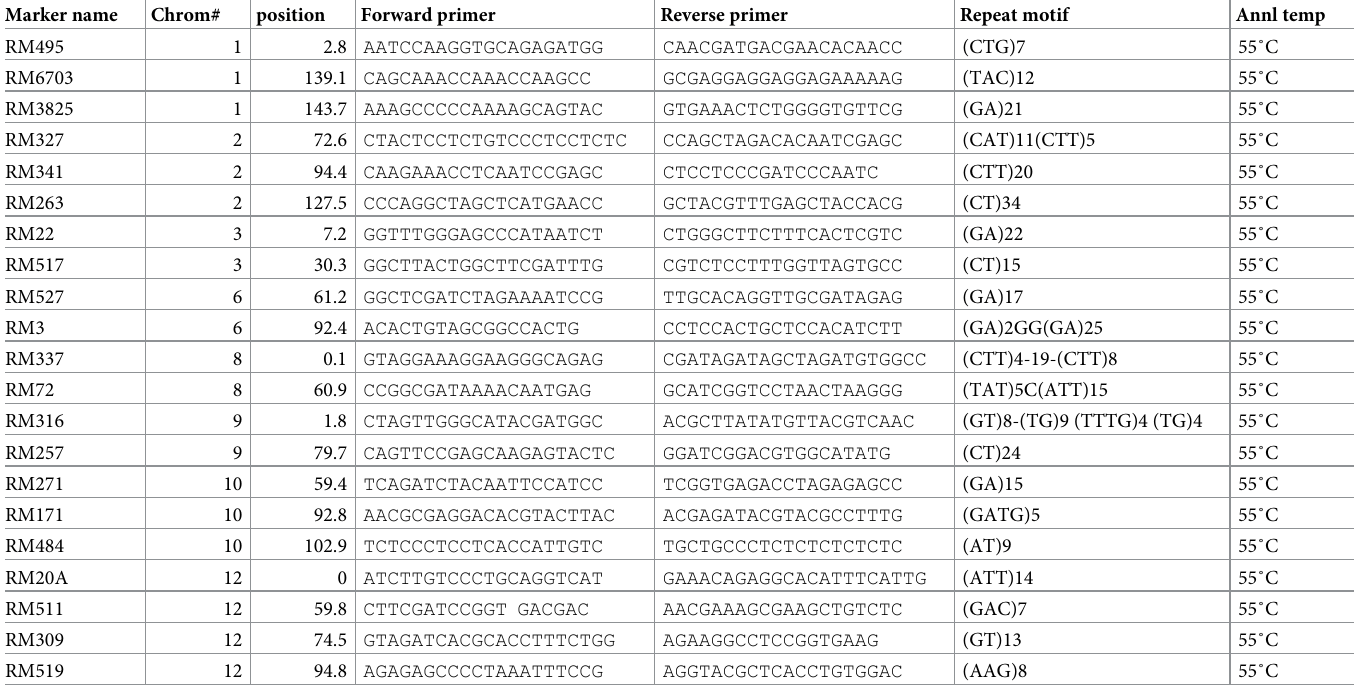
Table 2. Details of SSR markers detected in the genotyping of RILs using the polymorphic primers used in QTL